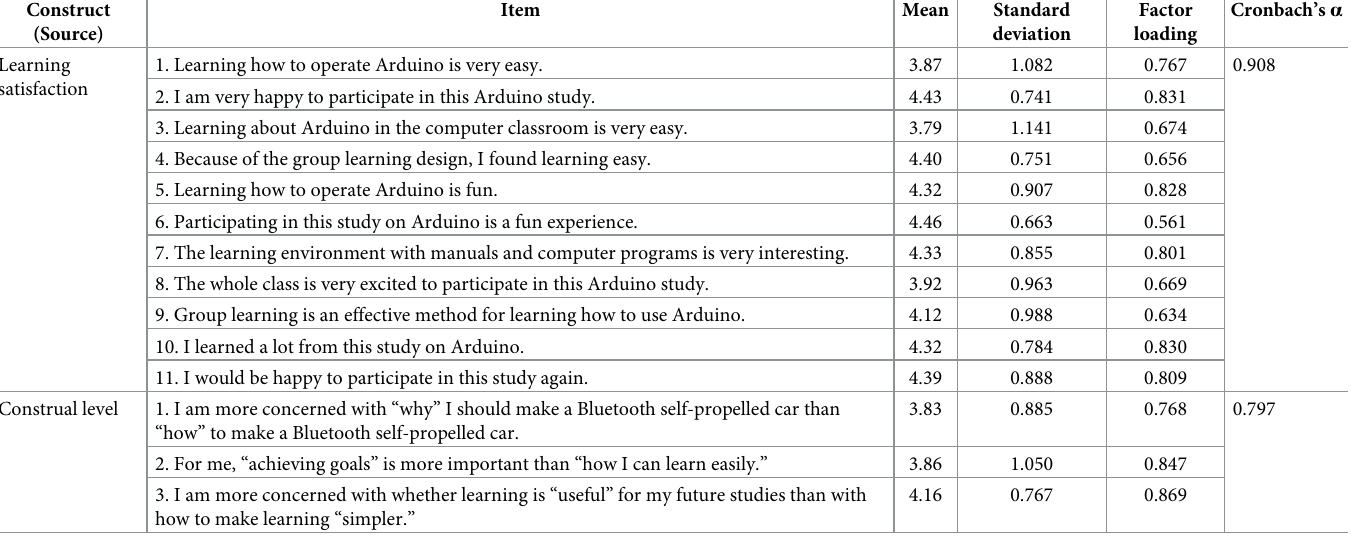
Table 1. Summary of the LS and CL